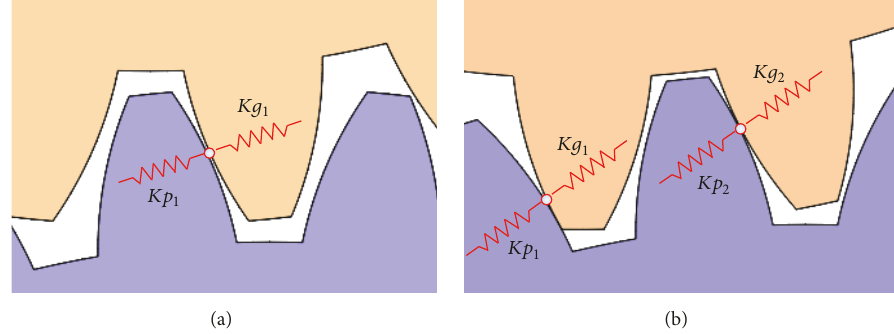
Figure 12: Equivalent stiffness between meshing teeth. (a) Single contact; (b) double contact.